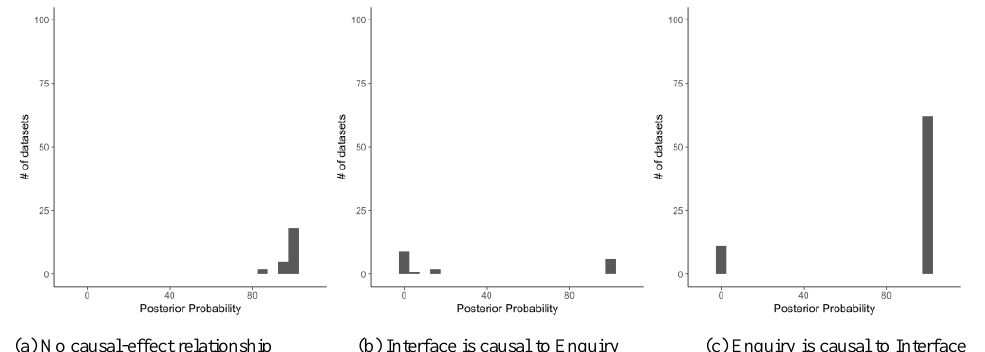
Fig. 9. Distributions of posterior probabilities between Interface and Enquiry in Finnish dataset when the